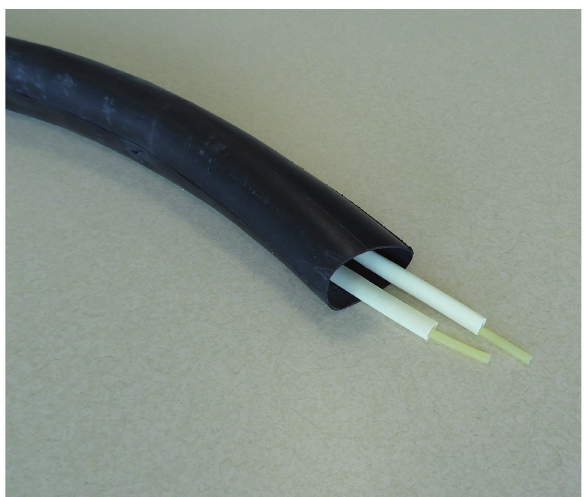
Figure 1 - The “vasa and fascia” inside the “scrotum”.